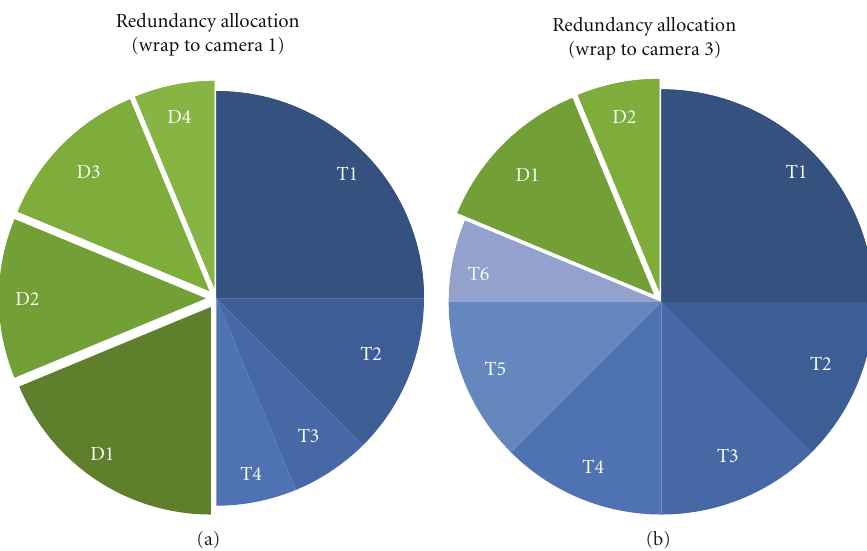
Figure 21: Allocation of the redundancy information between the various quality layers of texture (blue tones) and depth (green tones) information when observing from the viewpoints of Cam1 and Cam3.